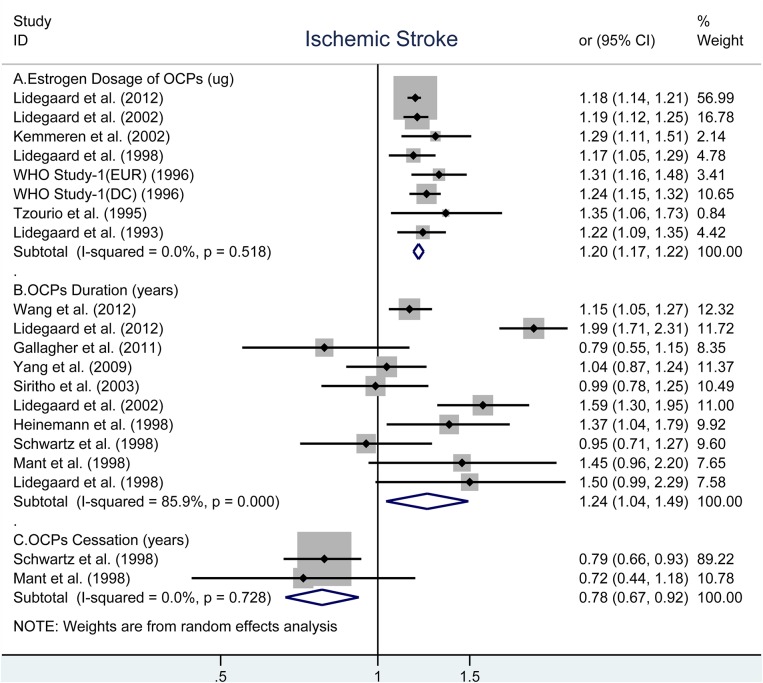
Forest plot of studies examining the association between OCP use [(A) estrogen dosage of OCPs, (B) OCPs duration, (C) OCPs cessation] and risk of ischemic stroke.